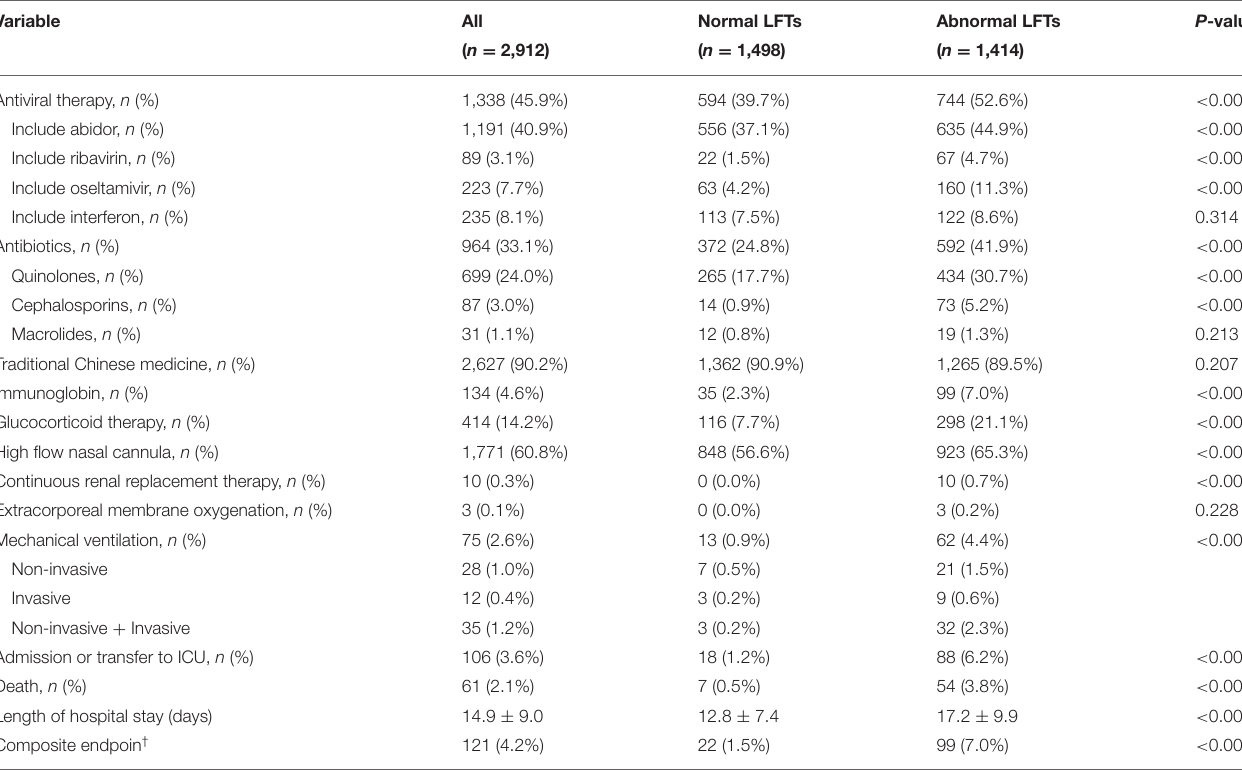
TABLE 2 | In-hospital treatment and outcomes according to normal vs. abnormal liver function on admission.